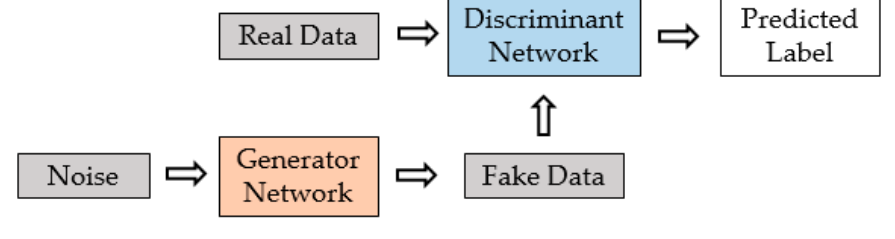
Figure 2. General diagram of a GAN.